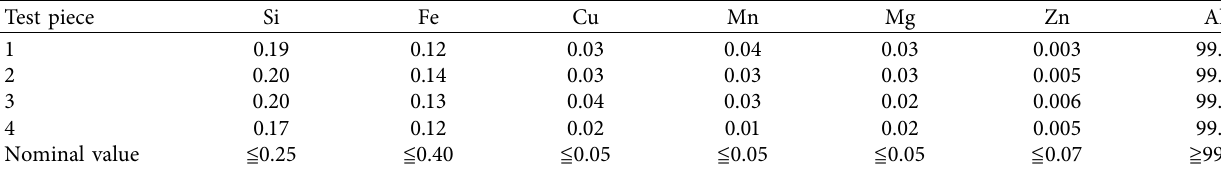
Table 2: Chemical compositions of the strain clamps (mass fraction).